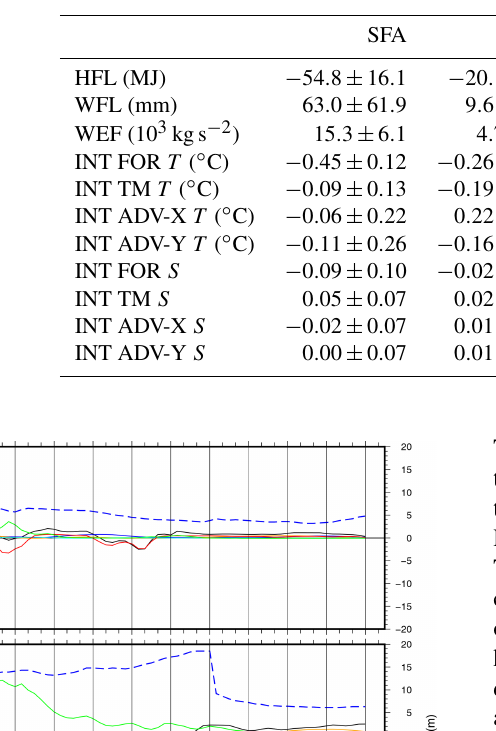
Table 3. Integrated forcings and effects of OML tendency terms between the beginning of the simulation (04:00UTC on 7 November) and 12:00UTC on 8 November in the different zones (see text). HFL is heat flux, and WFL is water flux.